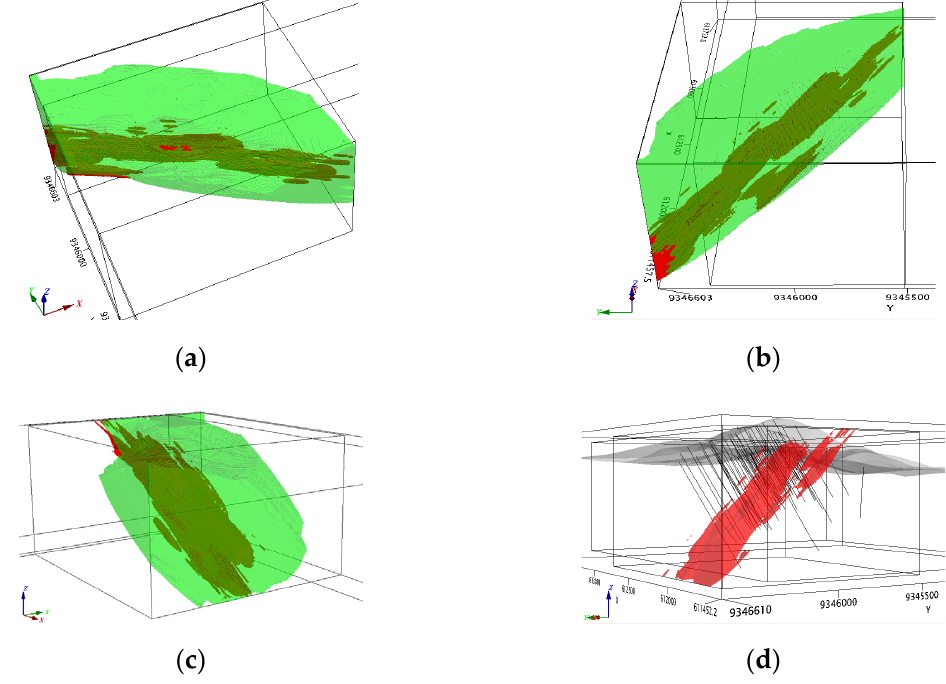
Figure 19. The 3D magnetic susceptibility models interpolated using a 3D kriging algorithm [46]. The red model includes hydrothermal alteration zones with predominant ferrimagnetic minerals footprints values greater than 500 × 10 − 3 SI from the high-sensitivity equipment (KT-10) and values greater than 60 × 10 − 3 SI for those measured with the low-sensitivity equipment (KT-9). The green model includes host rocks and hydrothermal alteration zones with predominant diamagnetic and paramagnetic minerals footprints with values lower than that cited above. The 3D kriging with 5 m cubic cells. Drill holes in black traces and topography in the gray surface. ( a ) Top view from SW to NE. ( b ) View from E to W. ( c ) View from SE to NW. ( d ) View from NW to SE. This susceptibility model versus ore concentration, when seen in detail, shows the direct correlation between the magnetite (Fe) hydrothermal alteration zones, represented by high magnetic susceptibility values (envelope of the values greater than 500 × 10 − 3 SI) (Figure 20a), and high-grade orebodies with values higher than 0.6% copper (Figure 20b). However, the Si alteration is represented by low magnetic susceptibility values and wraps the magnetic Fe alteration. The continuation of interpolation in depth can suggest the main interpreted trend of ore (Figure 20a). A dip difference can be observed between the sections, also on the right (Figure 20b) of the mineralized zones that crop out at the hill crest, whereas in the model (Figure 20a), the magnetic zone projects the surface downslope to the SW. These differences can be explained due to the absence of measurements on the weathered lateritic profile and interpolation algorithm